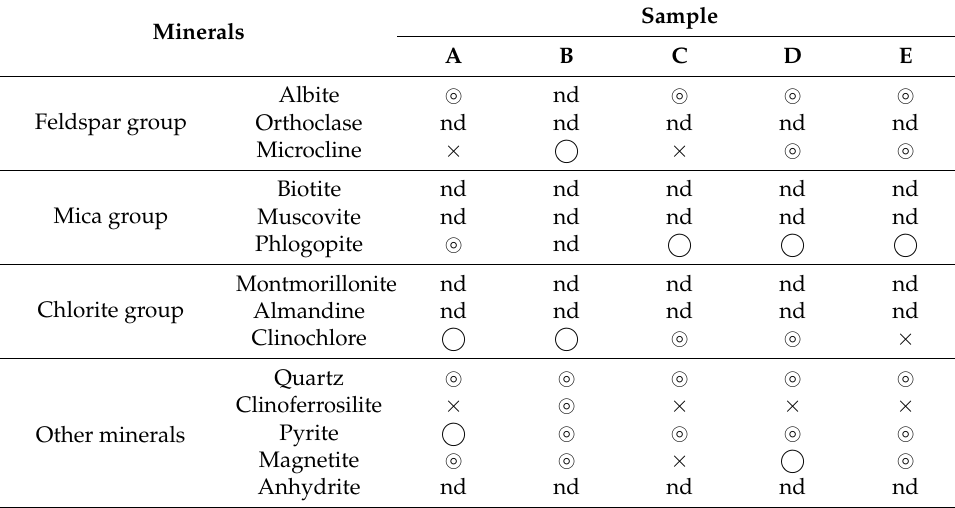
Table 4. Mineralogical analysis result of each ore sample measured by XRD.